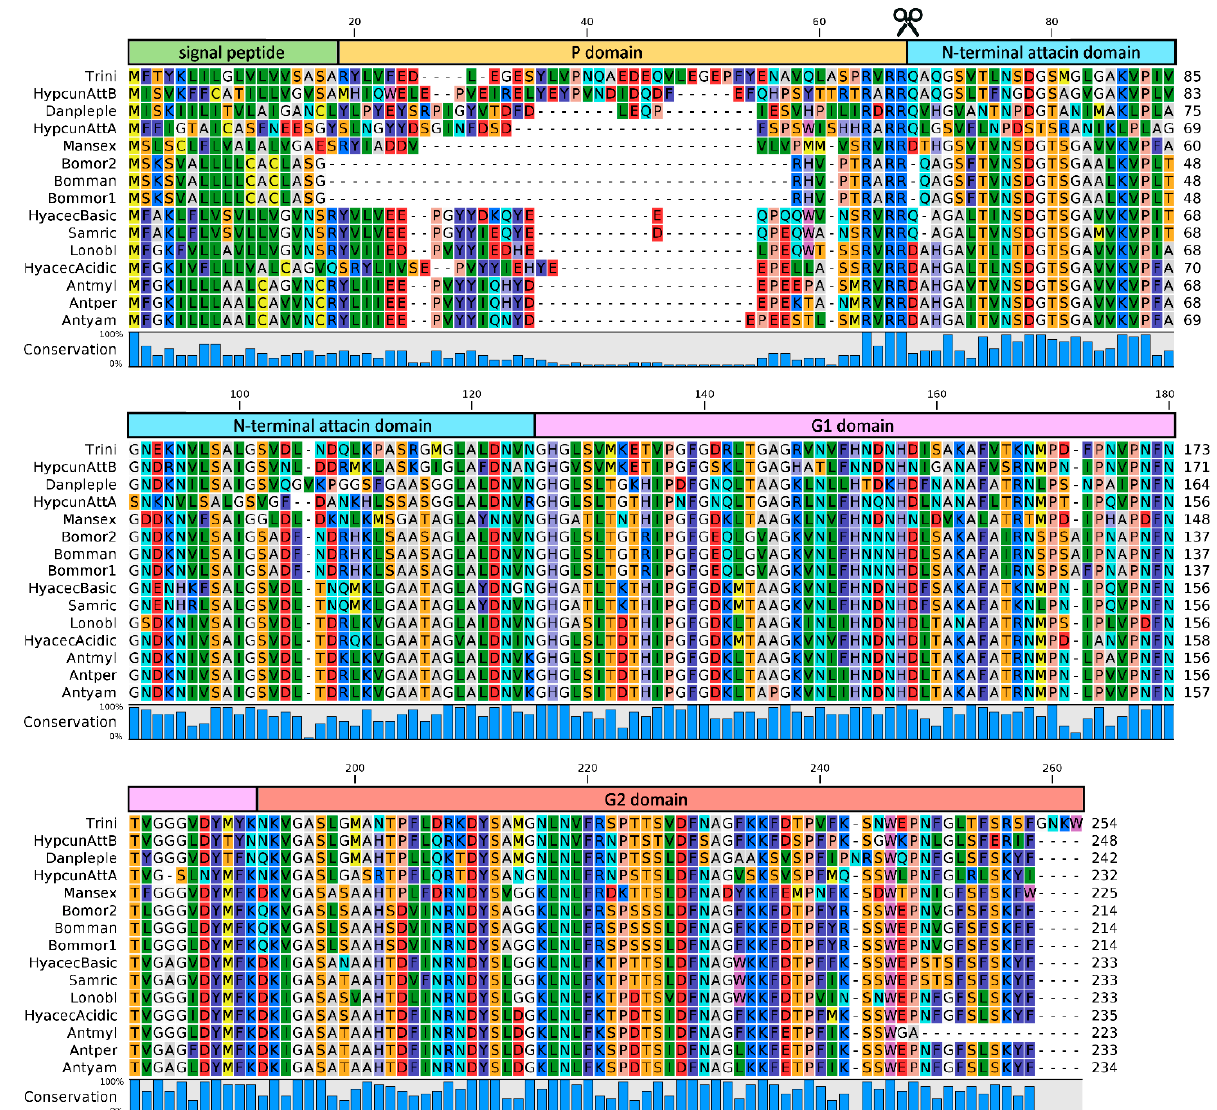
Figure 1. Alignment of attacin amino acid sequences from Lepidoptera obtained by Clustal ω . The predicted signal peptide and the different domains are highlighted above the sequences, together with the RXXR motif (indicated as cut symbol).